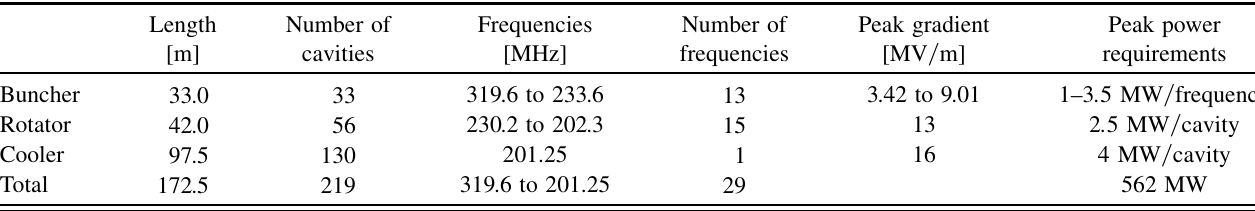
TABLE I. Summary of front-end rf requirements. Where power requirement is listed per frequency, this is the requirement per group of rf cavities of the same frequency. Where it is listed per cavity, this is the requirement per single rf cavity. The total installed rf voltage is 1184 MV.